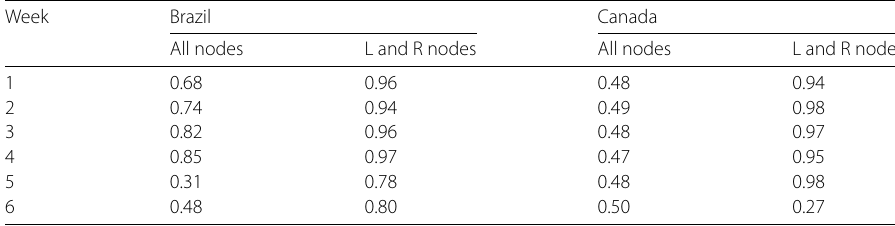
Table 2 Assortativity on retweet networks according to node’s political orientation Week Brazil Canada All nodes L and R nodes All nodes L and R nodes 1 0.68